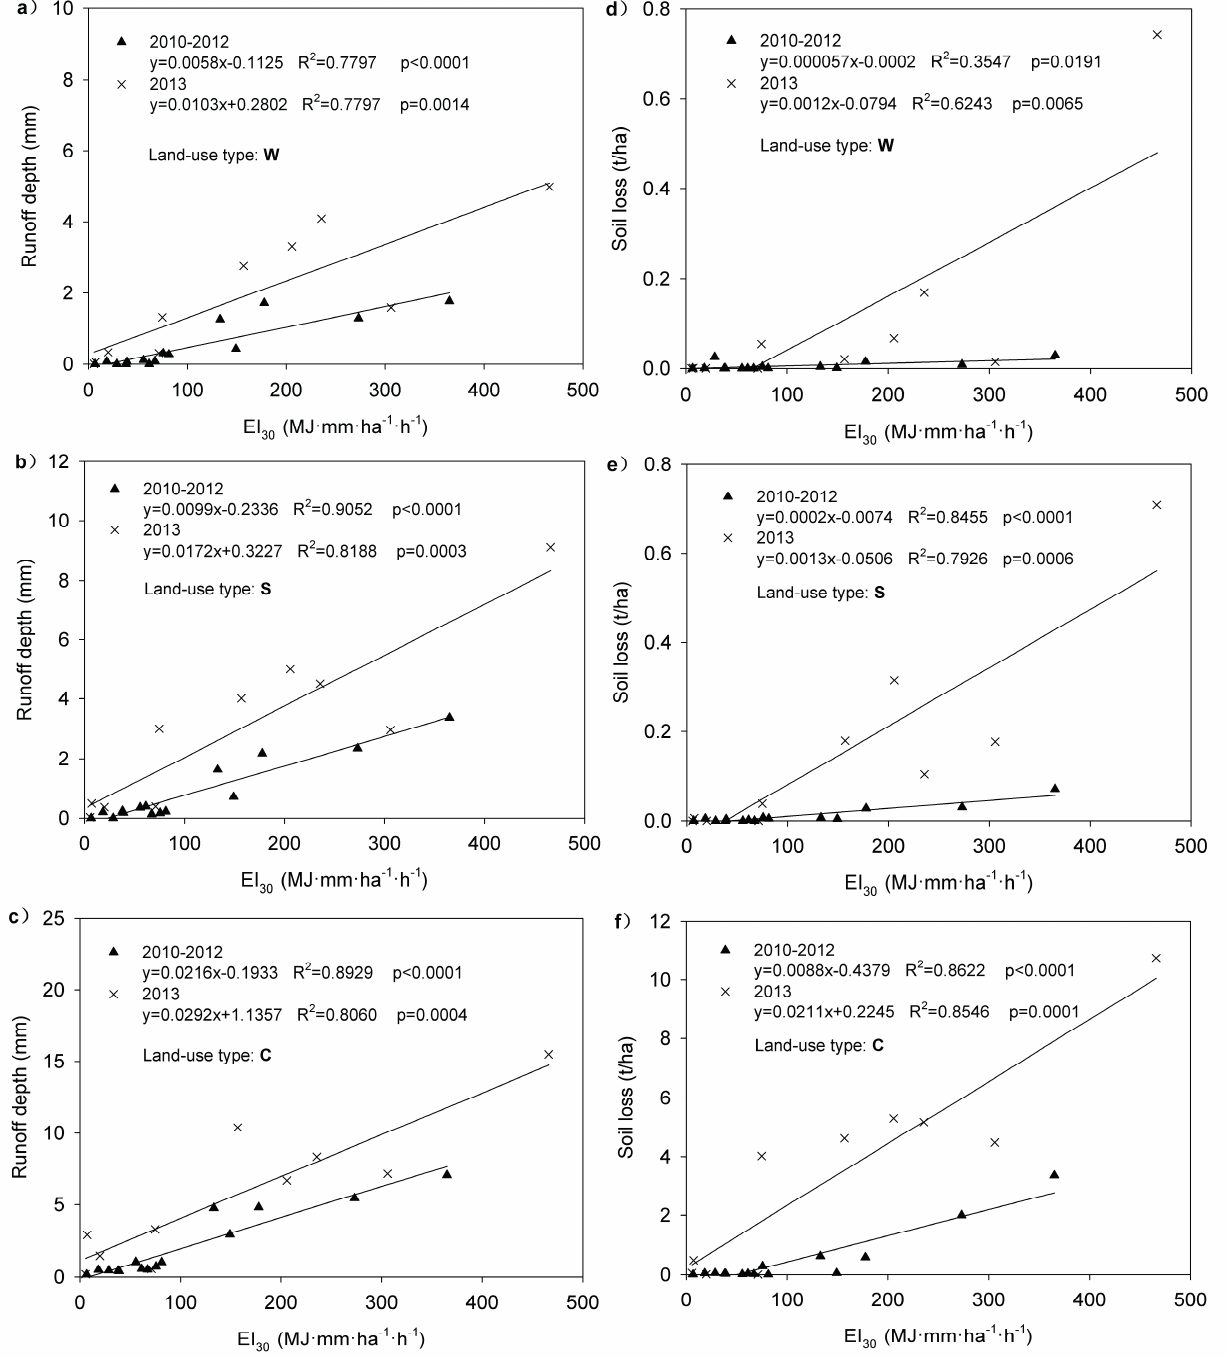
Figure 10. Linear-regression between EI 30 and runoff ( a , b , c ) and soil loss ( d , e , f ) for land use types in the “normal year” and “extreme